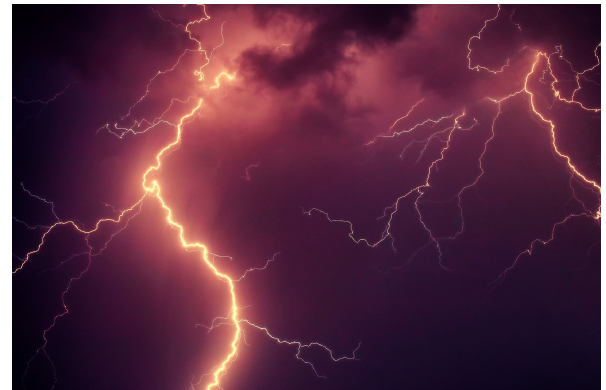
Figure 1. Lightning is a beautiful natural phenomenon.